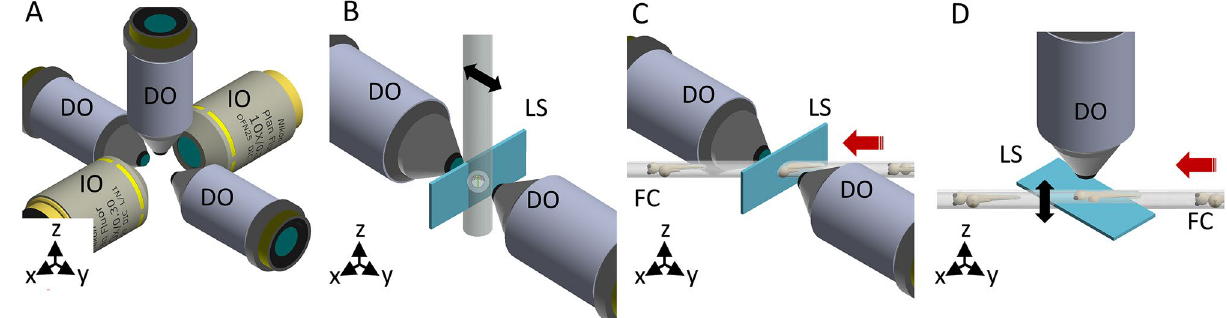
Figure 2. ( A ) The objectives’ configuration enabling multiple illumination/detection schemes. ( B ) Through the first mounting option the sample is embedded within a cylinder perpendicular to the optical table. The black arrow indicates the scanning direction. ( C ) The second approach uses the flow of the samples to scan them through the light sheet. The red arrow indicates the flow direction. ( D ) Through the third approach, the sample flow (red arrow) is used to position the sample in the objective’s FoV of the DO. The scanning of the specimen is obtained instead in the vertical direction (black arrow), either mechanically or optically. IO illumination objective, DO detection objective, LS light sheet, FC fluidic circuit. Figure created with Autodesk Inventor Professional 2015 (www. autod esk.